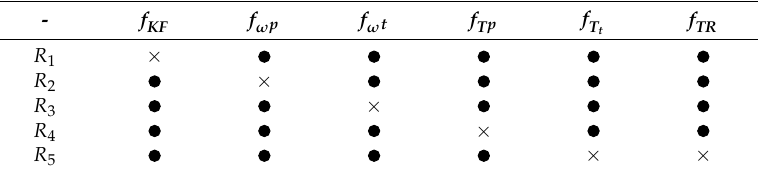
happens; (cid:3291)